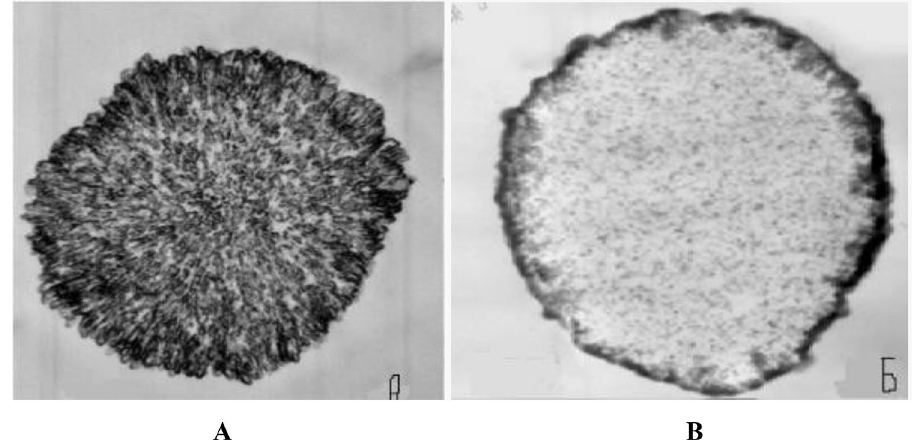
Figure 1. Electron microscopy of ultrathin slice of protein-free PMC ( A ) and PMC ( B ) containing protein 40 .